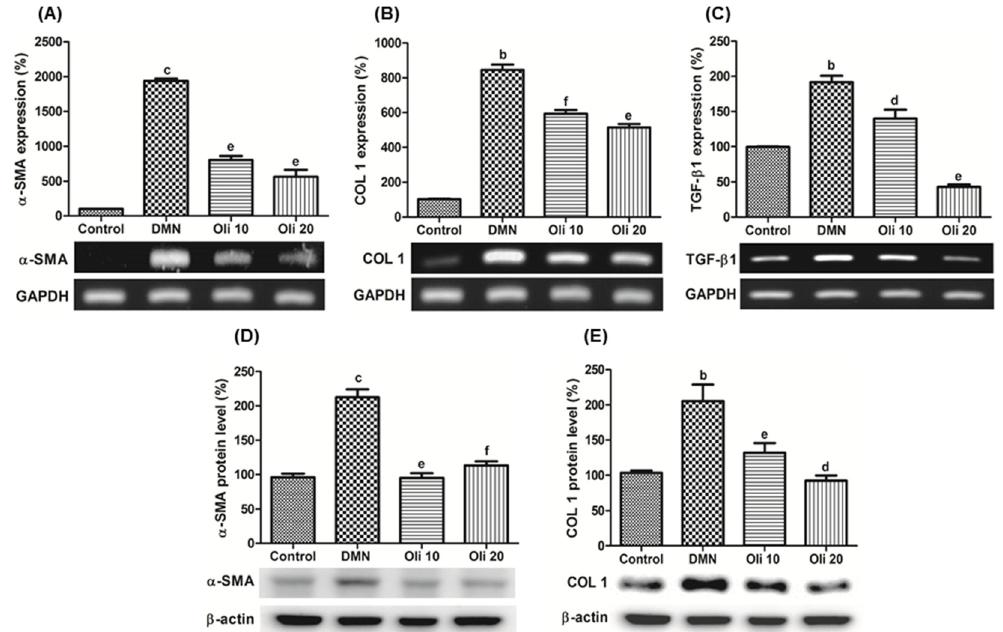
Figure 9. Effects of oligonol on the profibrogenic factors in the rat livers. RT-PCR was performed to measure mRNA expression of α -SMA ( A ), COL1 ( B ), and TGF- β 1 ( C ). Western blot analysis was performed to measure α -SMA ( D ) and COL1 ( E ) protein levels. Values are mean ± SE ( n = 3). b p < 0.01 and c p < 0.001 vs. the control group, and d p < 0.05, e p < 0.01, and f p < 0.001 vs. the DMN group.